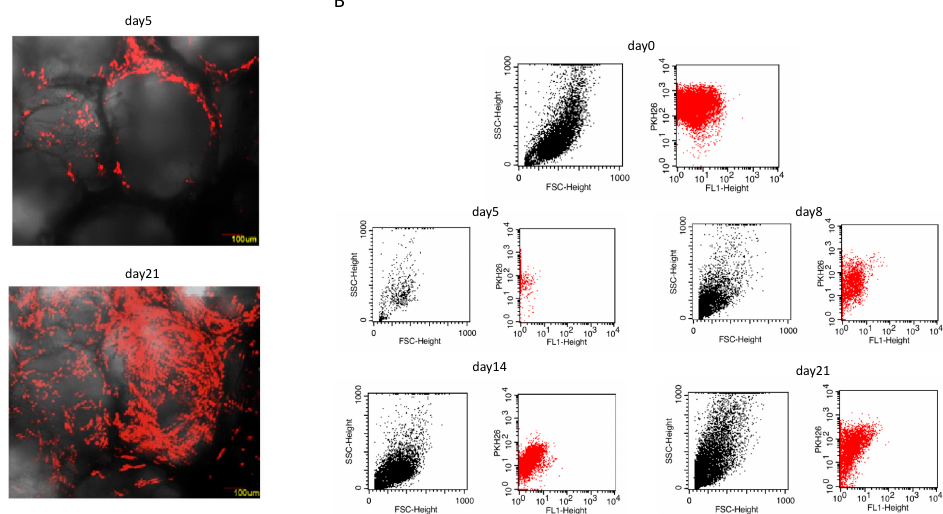
Figure 6. WJ-MSC, labelling with the fluorescent dye PKH26, grown in 3D culture on silk scaffold analyzed by CLSM ( A ) and flow cytometer ( B ). ( A ) Cells grown on SF on the 5th and 21st days. ( B ) PKH26-WJ-MSC after being detached from scaffolds and analyzed at different times of culture.